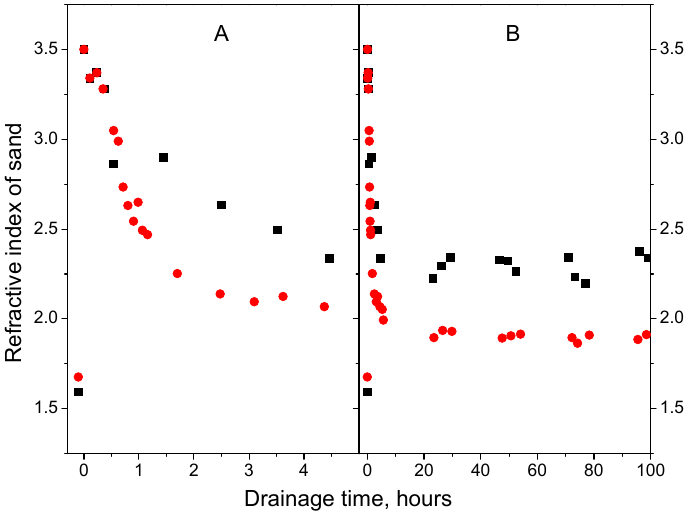
Figure 7. Dependence of the refractive index of a sand on water drainage time of on the narrow ( A ) and wide ( B ) time intervals. Calculation using Equation (5): black squares ■ —experiment 1; red circles ● —experiment 4.